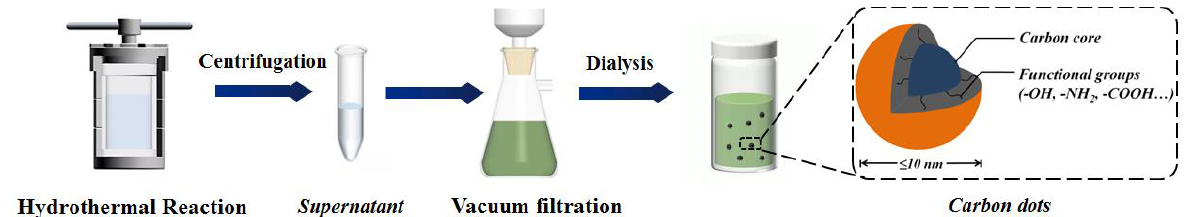
Figure 1. Fabrication diagram of N,Fe-CDs.